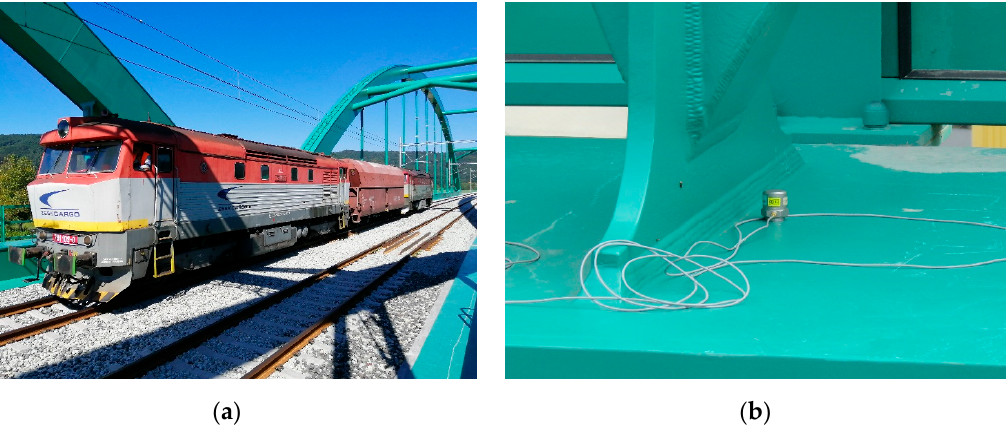
Figure 19. ( a ) View on the test train moving across the bridge. ( b ) View on the accelerometer of type 8344 located on the rigid beam.